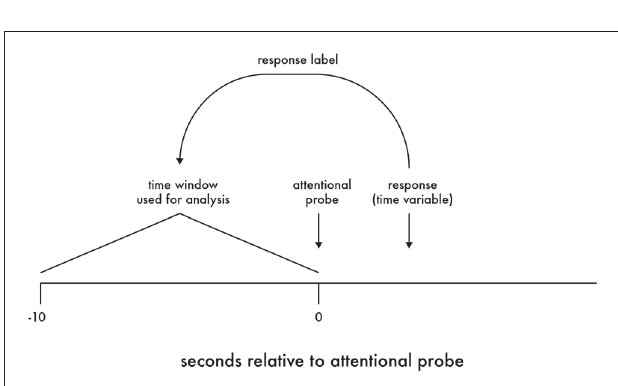
FIGURE 2 | Labeling of data for analysis.